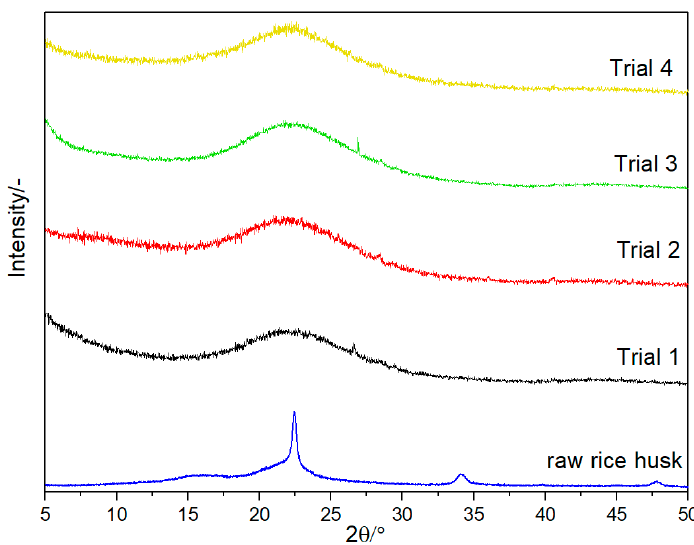
Figure 12. XRD patterns of the rice husk and the pyrolyzed samples.